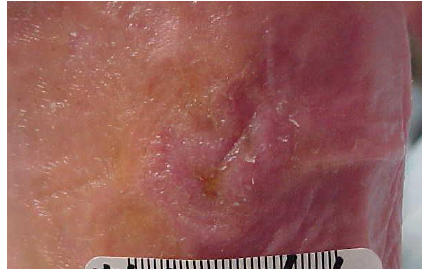
Figure 9. Appearance of wound at week 15.